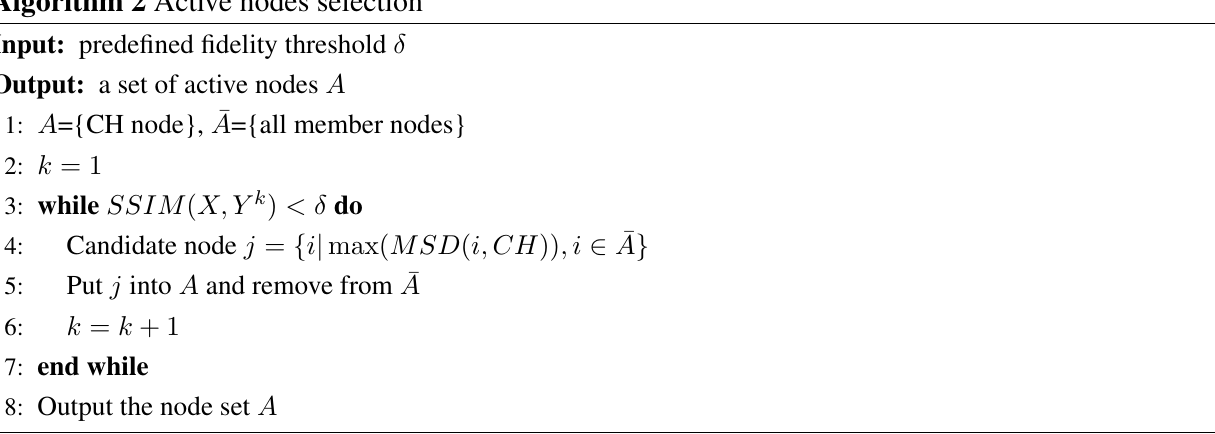
Algorithm 2 Active nodes